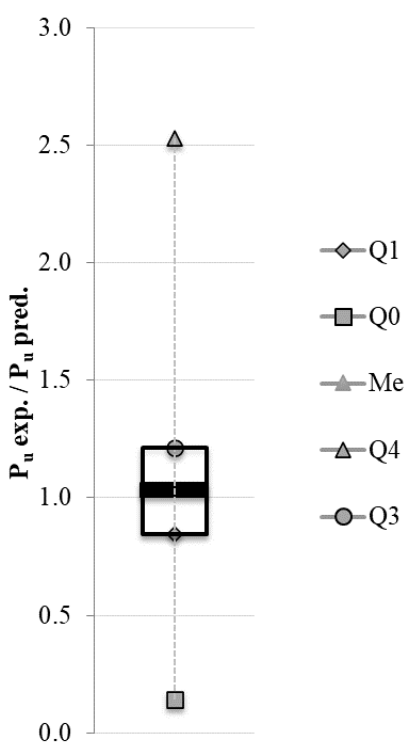
Figure 6. Box-plot of the frequency of the experimental/predicted values of P u .